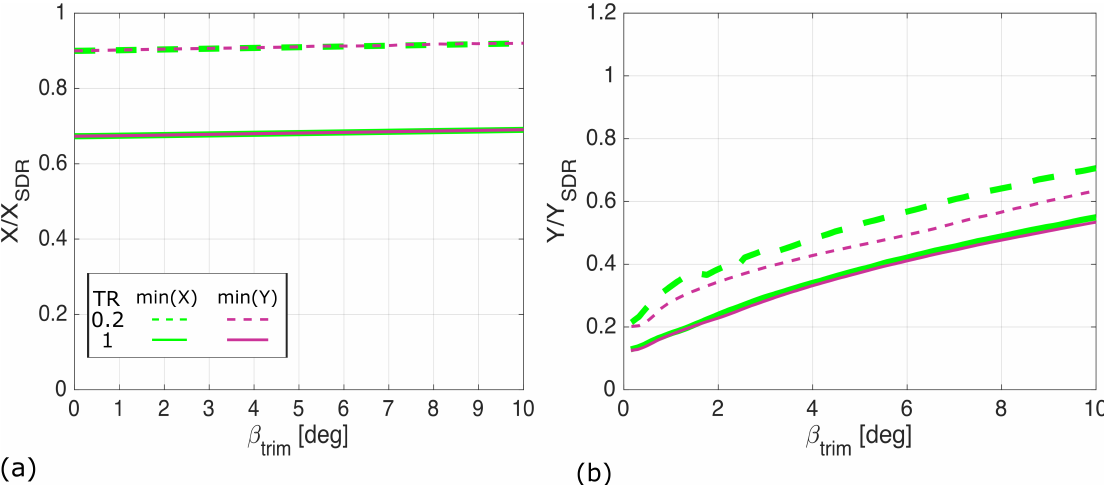
Figure 8. Optimisation functions aerodynamic efficiency ( a ) and aggregate control deflection ( b ) objectives for an unswept wing normalised by the same metrics for a SDR. Variations are shown up to a given sideslip trim angle of 10